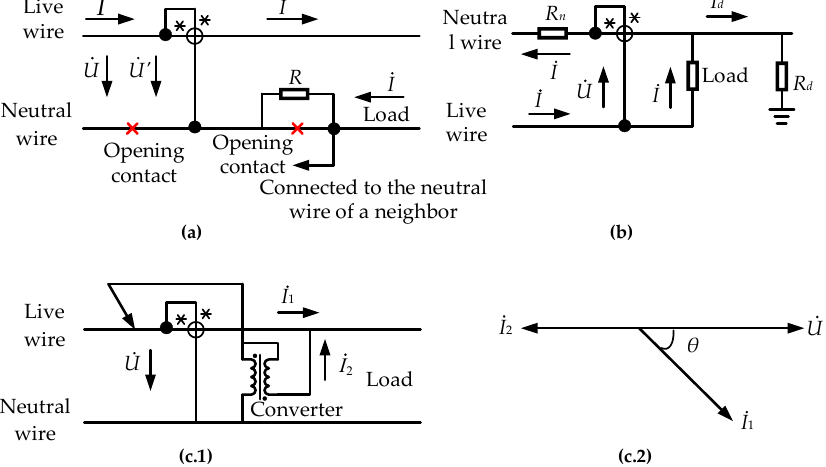
Figure 1. Three types of physical electricity theft methods. ( a ) Voltage reduction type wiring dia- gram. ( b ) Current reducing type wiring diagram. ( c.1 ) Power factor reduction type wiring dia- gram. ( c.2 ) Power factor reduction type phase